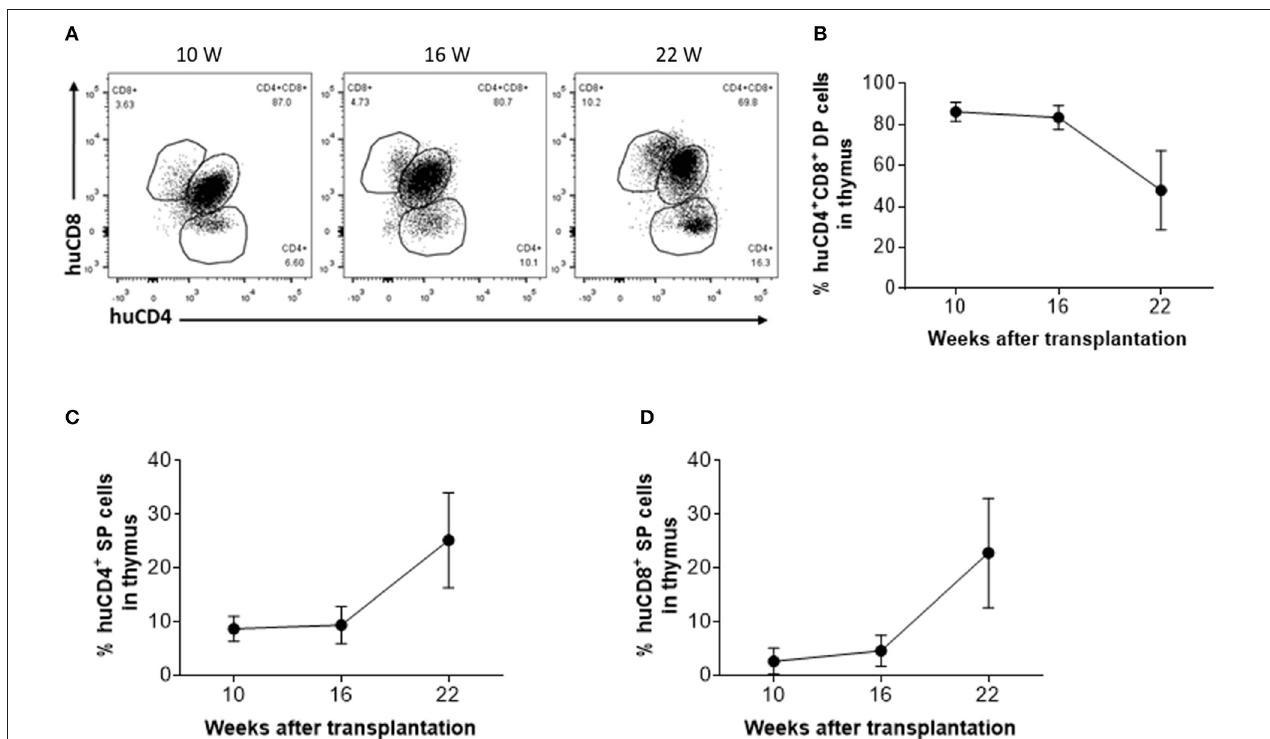
FIGURE 3 | Phenotypic distribution of human thymocytes in humanized mice. (A) Representative FCM profiles of CD4 and CD8 expression on human thymocytes. (B–D) Percentages of DP (B) , CD4 SP (C) and CD8 SP (D) thymocytes at the indicated time points ( n = 3–4 animals were analyzed at each time